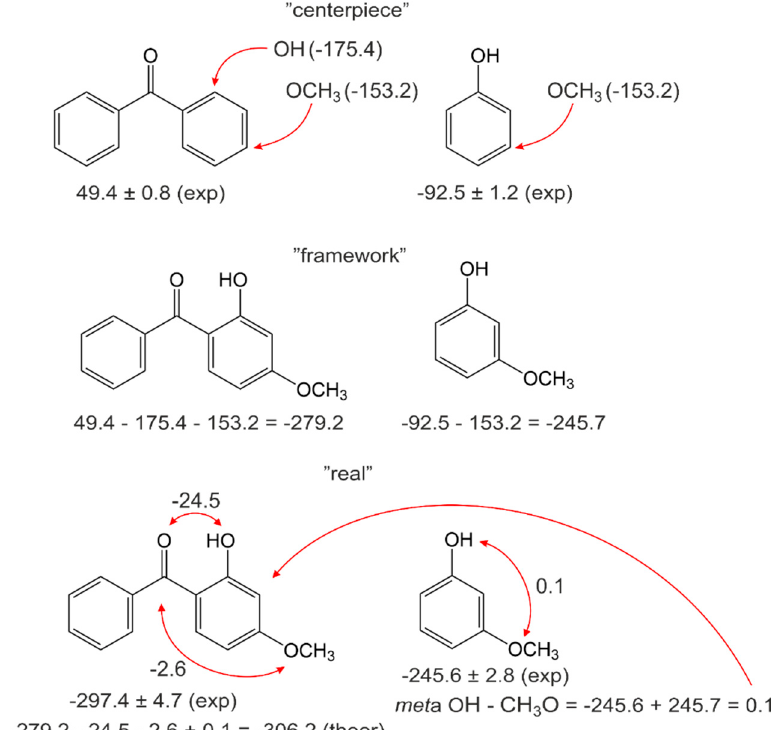
Figure 8. Example of calculation of the enthalpy of formation, ∆ f H o m (g, 298.15 K), of 2-hydroxy-4- methoxy-benzophenone using the “centrepiece” approach with the numerical values from Table 9. All numbers are given in kJ · mol −− 1